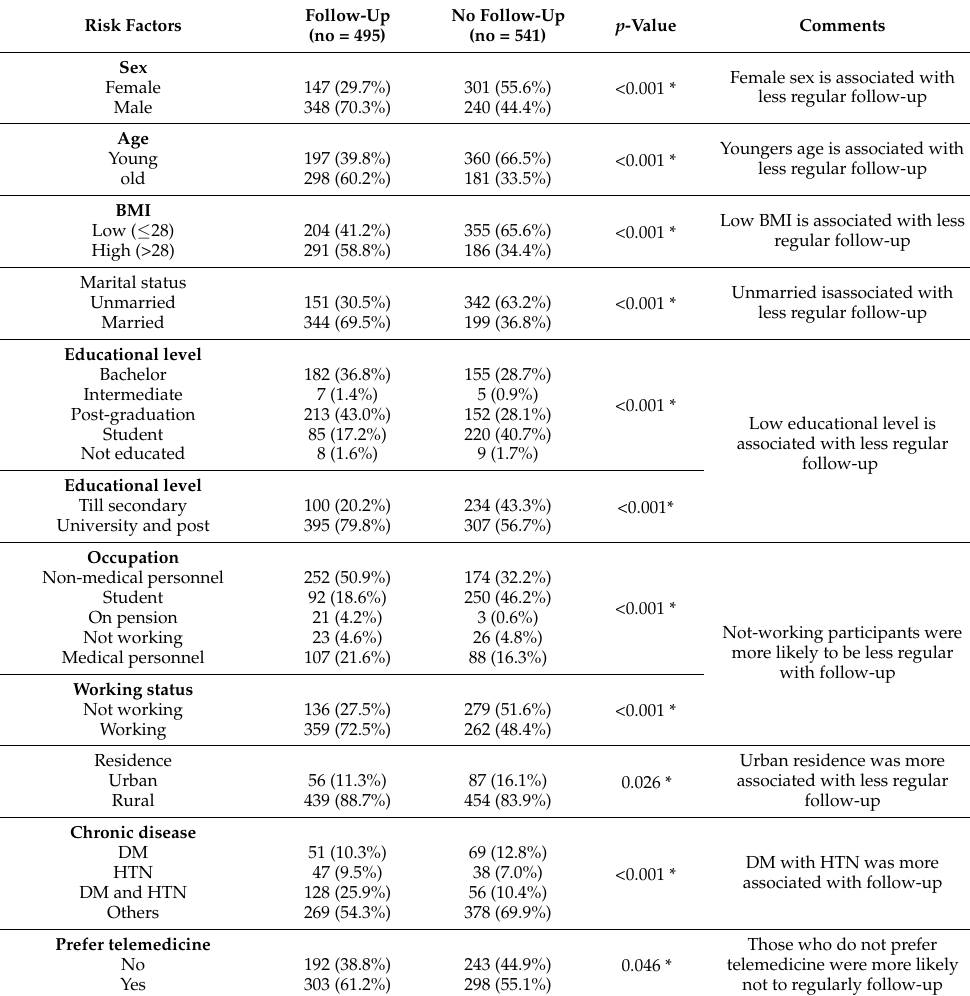
Table 5. Univariate analysis for risk factors associated with less regular follow-up of chronic disease during the COVID-19